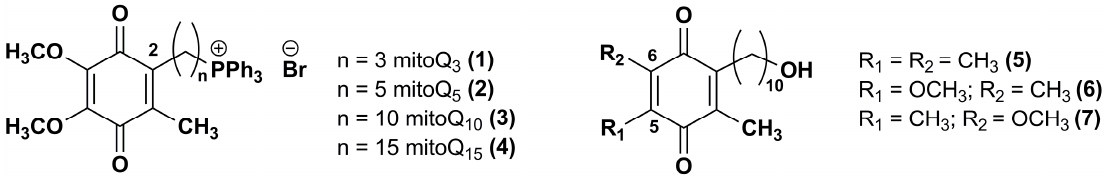
Figure 2. Chemical structures of IDE analogues modified at carbon 2 or 5 and/or 6.